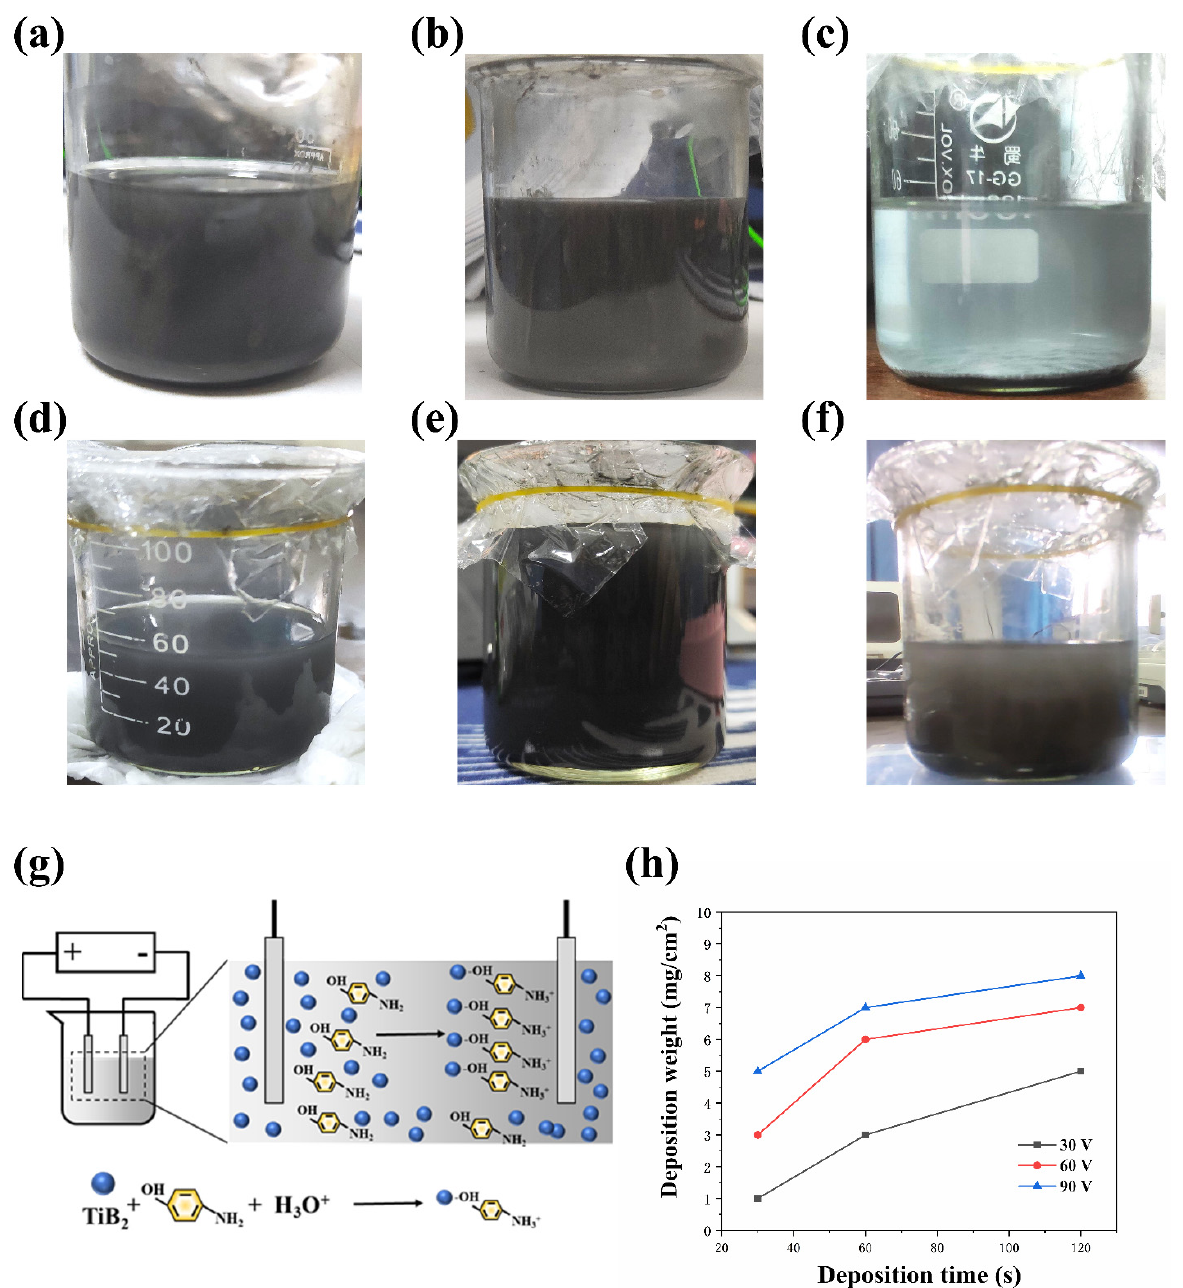
Figure 3. The suspensions with different concentration of TiB 2 and Chitosan: ( a ) 2.5 g/L TiB 2 and 0.5 g/L Chitosan, ( b ) 5 g/L TiB 2 and 0.5 g/L Chitosan, ( c ) 10 g/L TiB 2 and 0.5 g/L Chitosan, ( d ) 2.5 g/L TiB 2 and 1 g/L Chitosan, ( e ) 5 g/L TiB 2 and 1 g/L Chitosan, ( f ) 10 g/L TiB 2 and 1 g/L Chitosan ( g ) The mechanism of the EPD, ( h ) The deposition weight of different samples.